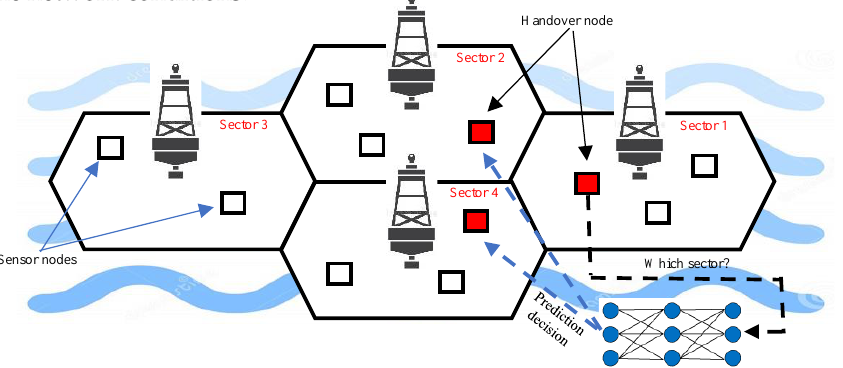
Figure 1. Schematic diagram of the use of machine learning models to predict the handover of a sensor node in a